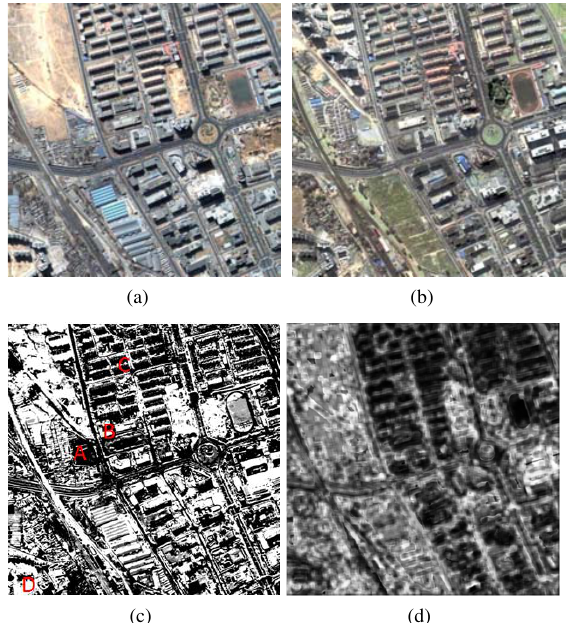
Figure 1: Illustration of difficulties in change detection of VHR images. (a) and (b):a multi-temporal image pair. (c)change features based on the pixel-wise difference. (d)change features based on the SIFT descriptor